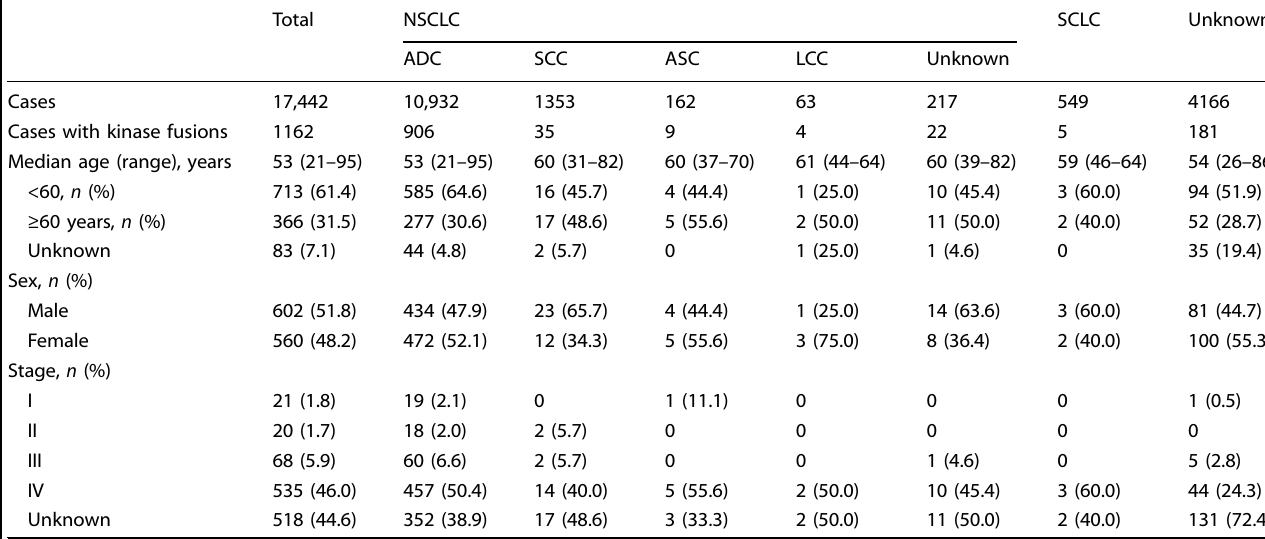
Table 1. Summary of the demographic and clinical characteristics of the kinase fusion cohort in this study.